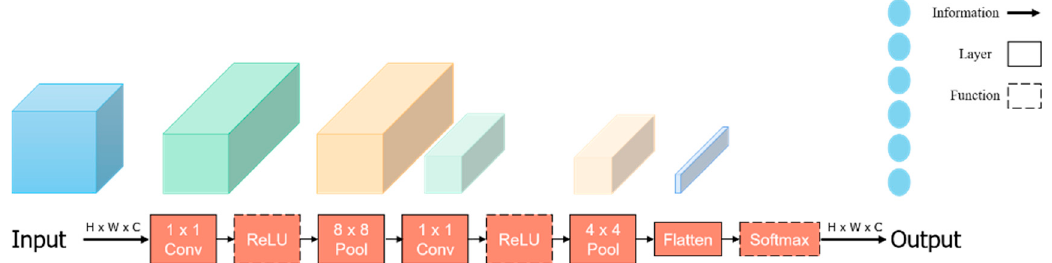
Figure 1. Schematic diagram of the CNN model.